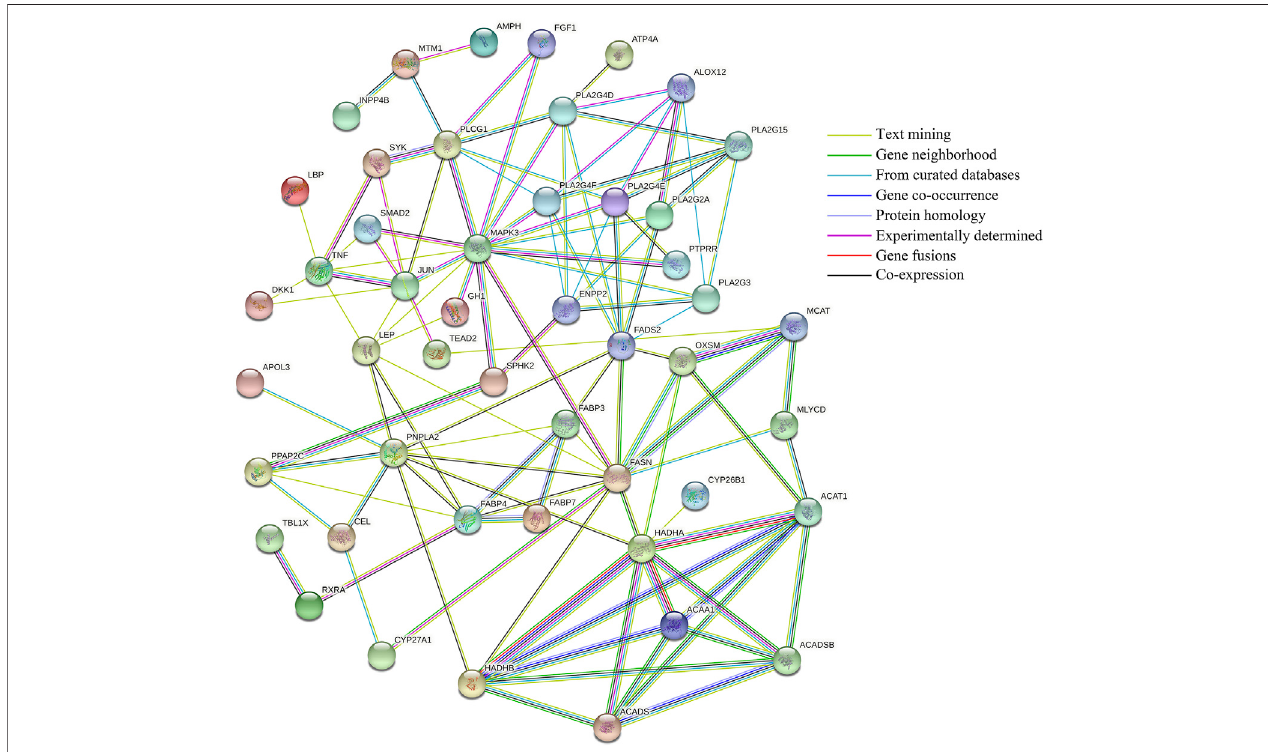
FIGURE 10 | Protein interaction network analysis. Lines of different colors indicate different supporting evidence for protein interactions.